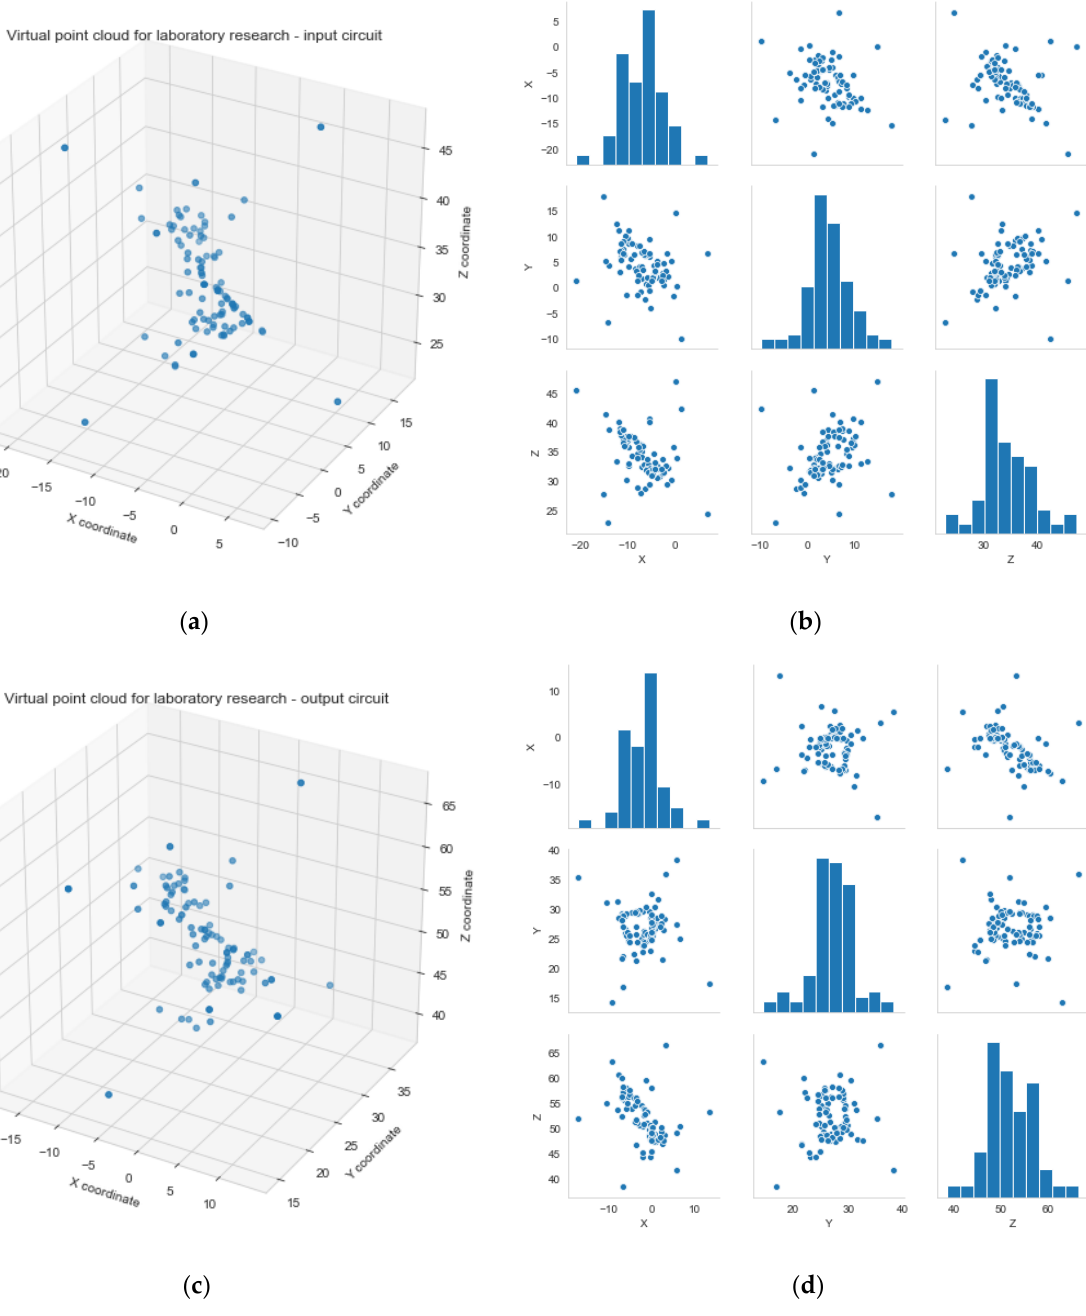
Figure 5. Virtual point cloud for laboratory research. Input coordinate system—( a ) points distribution, ( b ) coordinates correlation diagram; output coordinate system—( c ) points distribution, ( d ) coordinates correlation diagram.